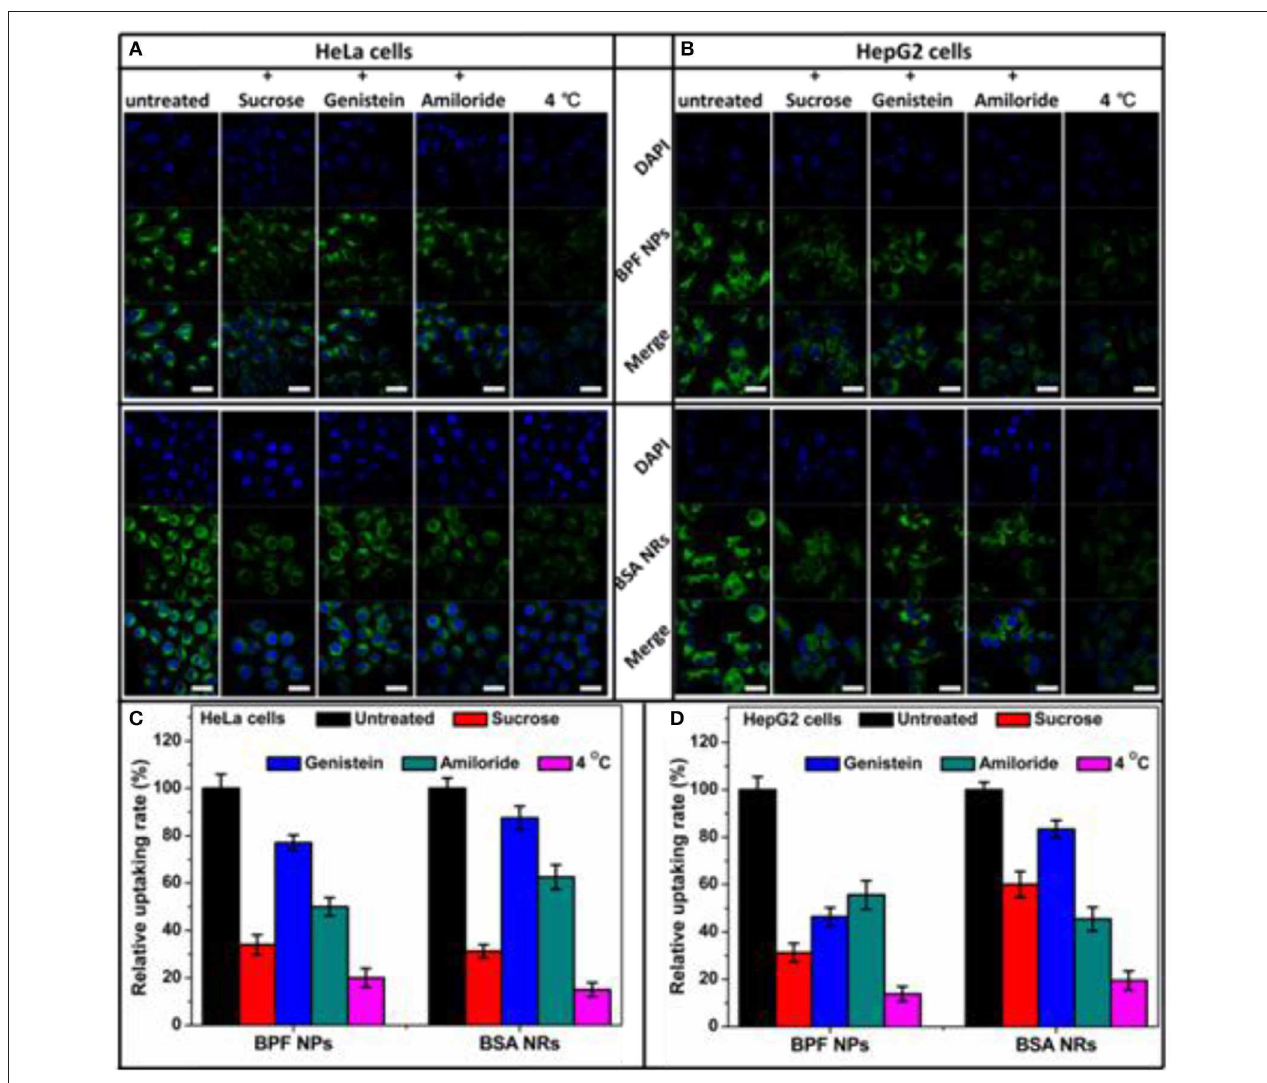
FIGURE 5 | Flow cytometry histograms of (A) HeLa cells and (B) HepG2 cells treated with BPF NPs, BSA NRs and control pretreated with various endocytic inhibitors, respectively. (C) Quantitative analysis of (A) . (D) Quantitative analysis of (B) . The data are presented as the mean values ± standard deviation, n =